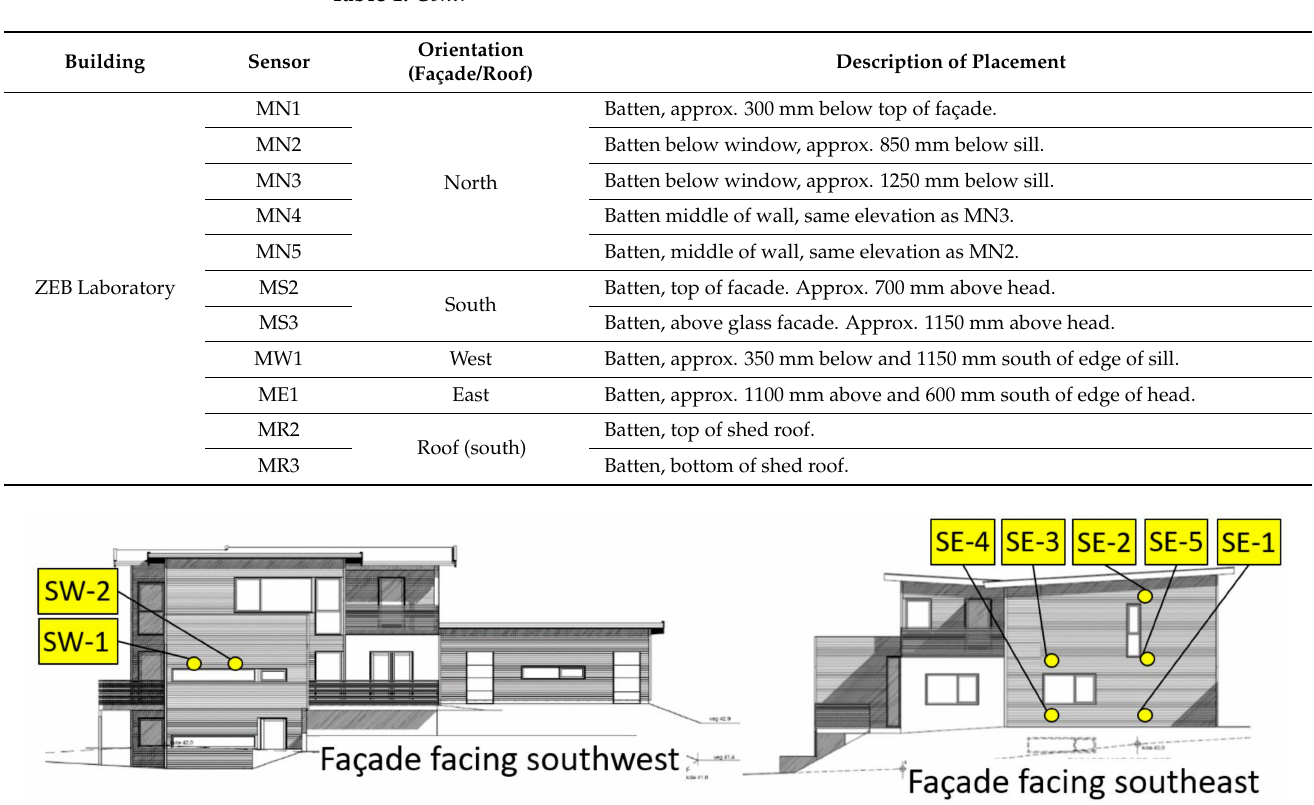
Figure 4. Sensor positions for Fjogstad-hus.